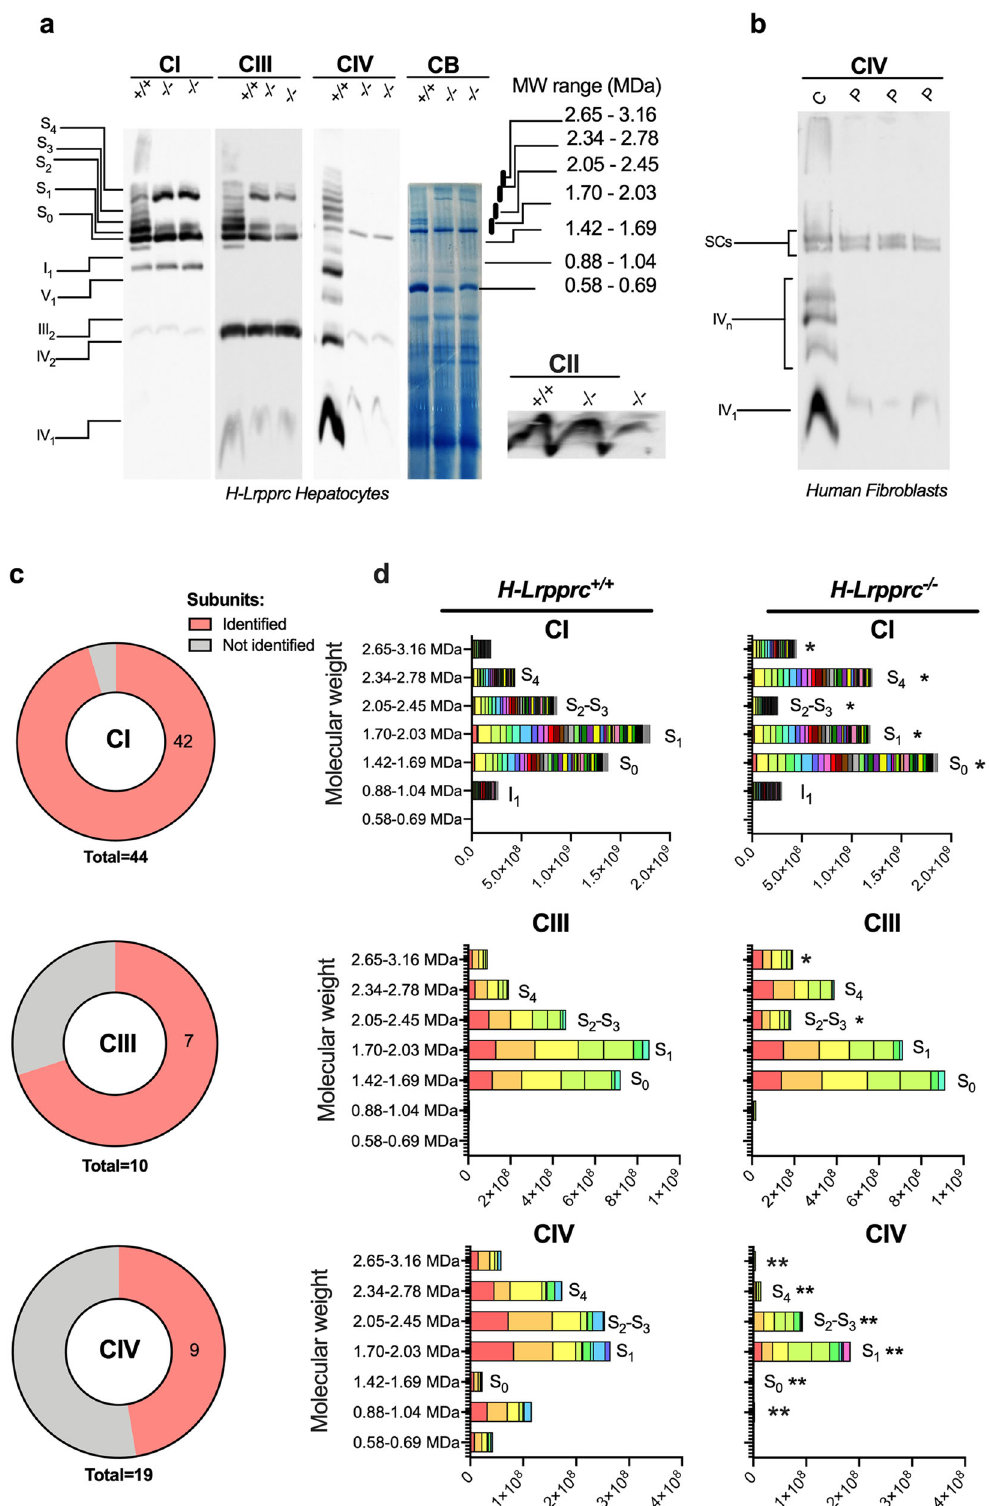
phosphatidylcholines (PCs), and the non-bilayer forming GPL phosphatidylethanolamines (PEs) as well as cardiolipin (CLs), which together make up ~90% of total mitochondrial GPL 29 . Volcano plot representation of the data highlighted the most signi fi cant changes, using a Q -value of < 0.05 (corresponding to P < 0.007) and a relative fold change (FC) threshold of 1.5 and 0.75, in mitochondrial membrane lipids from H- Lrpprc − / −